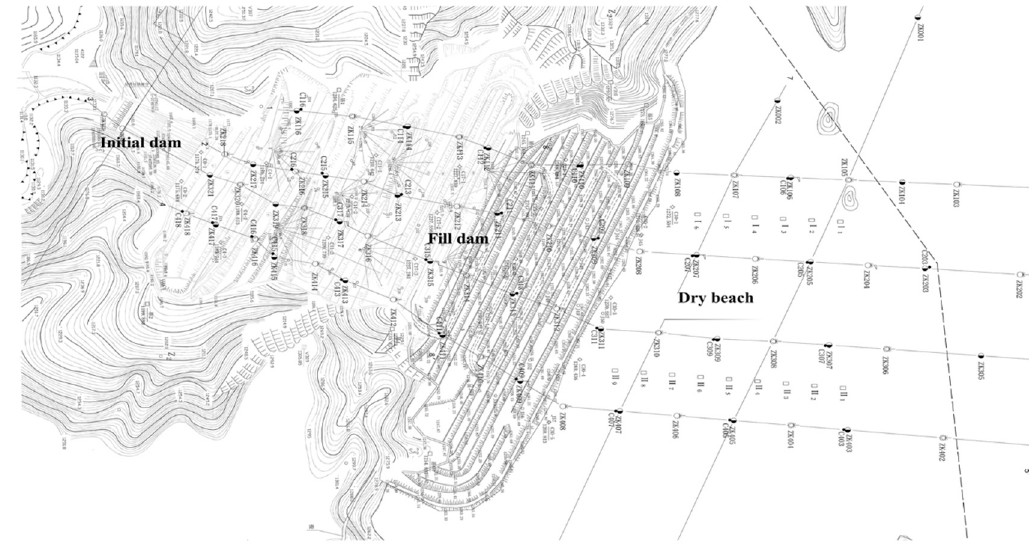
Figure 3. The layout of the project.